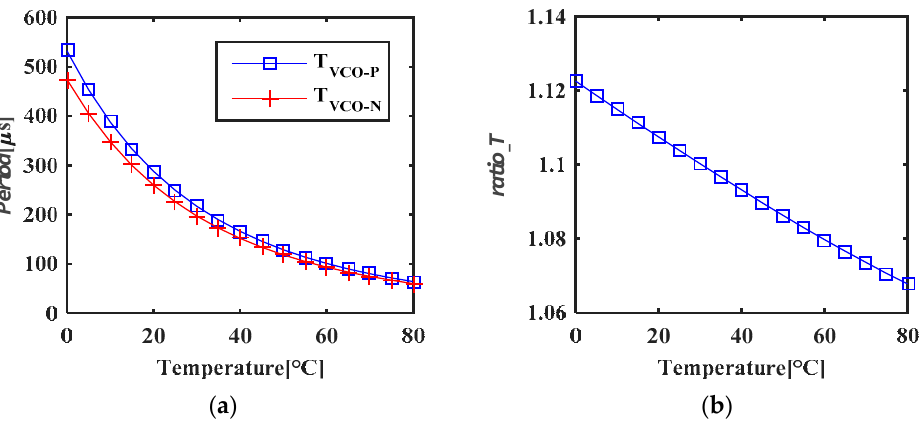
Figure 10 Simulated temperature performance of VCO ( a ) periods vs. temperature ( b ) Figure 10. Simulated temperature performance of VCO ( a ) periods vs. temperature ( b ) ratio_T vs. ratio_T vs. temperature